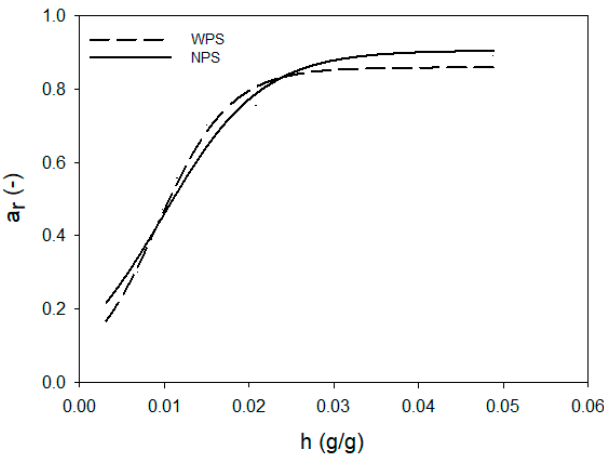
Figure 1. Changes in the equilibrium value of water activity during hydration of native potato starch aerogels.